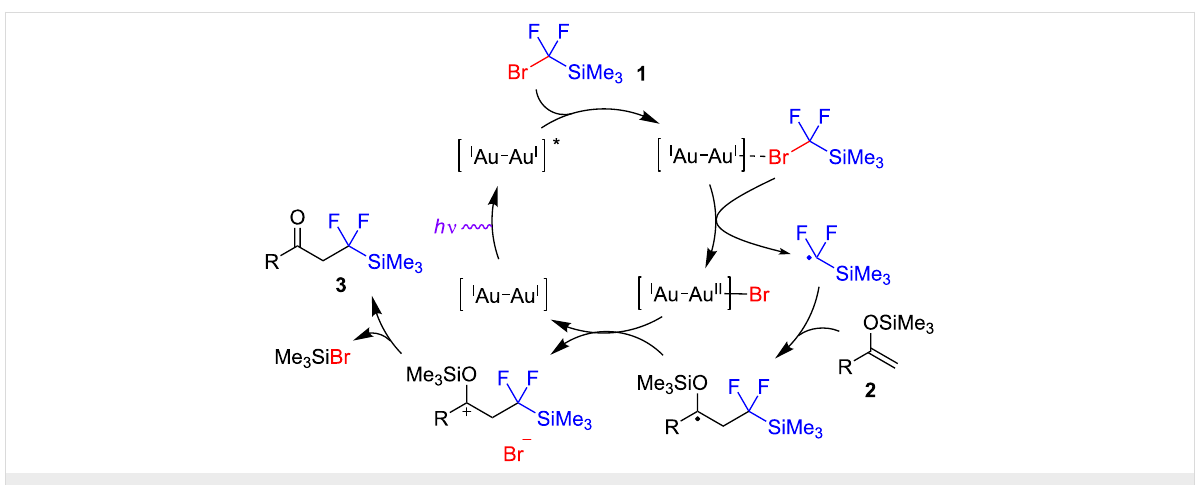
Scheme 3: Proposed mechanism of the fluoroalkylation